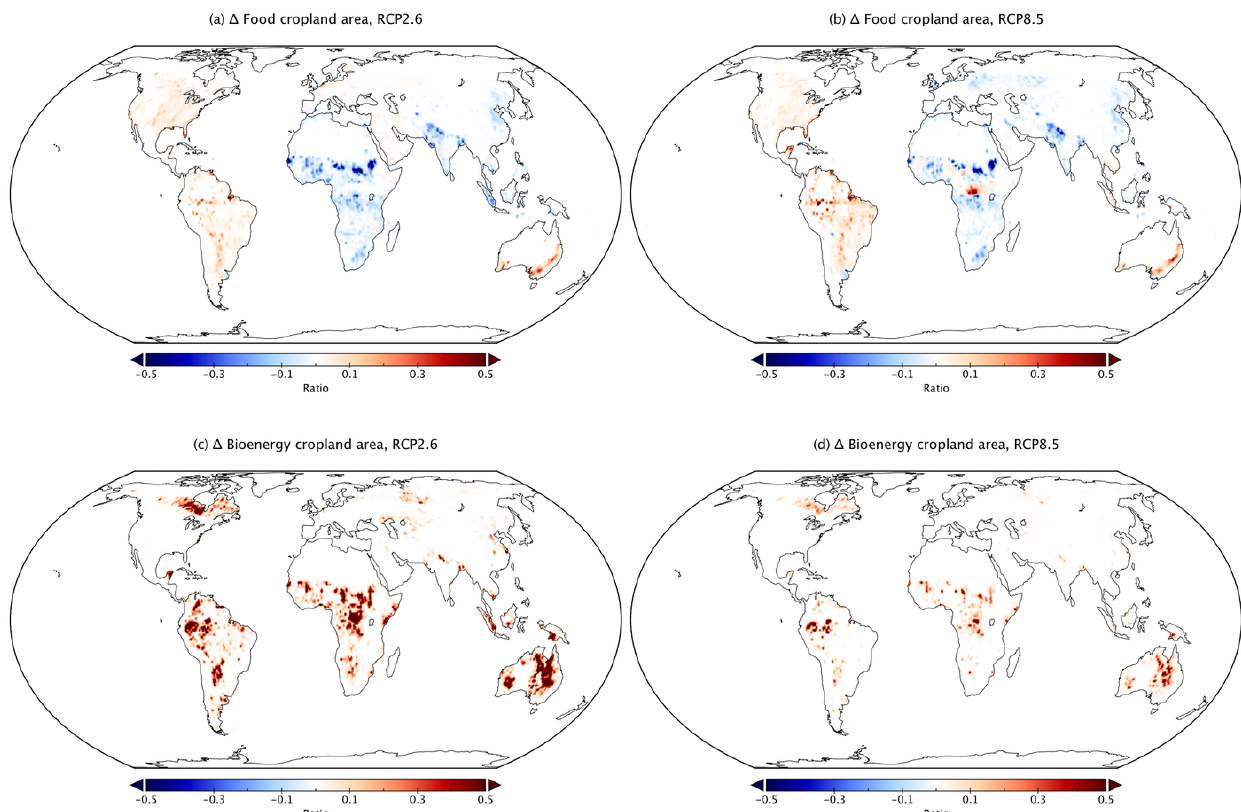
Figure 15. Spatial distribution of land-use-induced changes in terrestrial ecosystem carbon stock. Results are for (a, b) vegetation biomass and (c, d) soil carbon stock. Average of the five climate projection-based simulations under (a, c) RCP2.6 and (b, d ) RCP8.5 scenarios in the